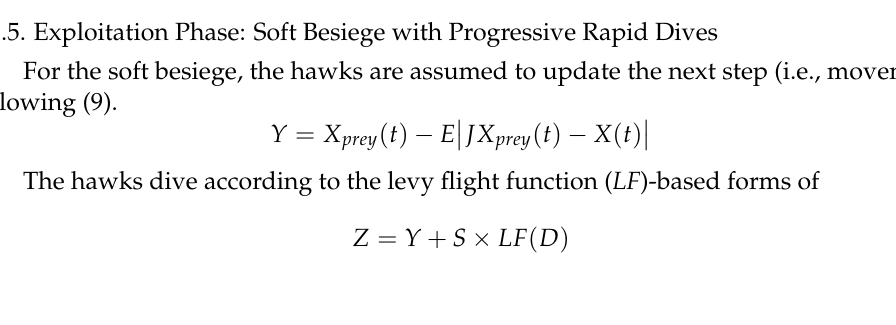
Figure 6. Example of overall vectors in hard besiege case.